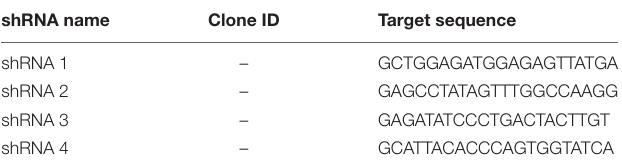
TABLE 1 | shRNA sequences for knockdown of